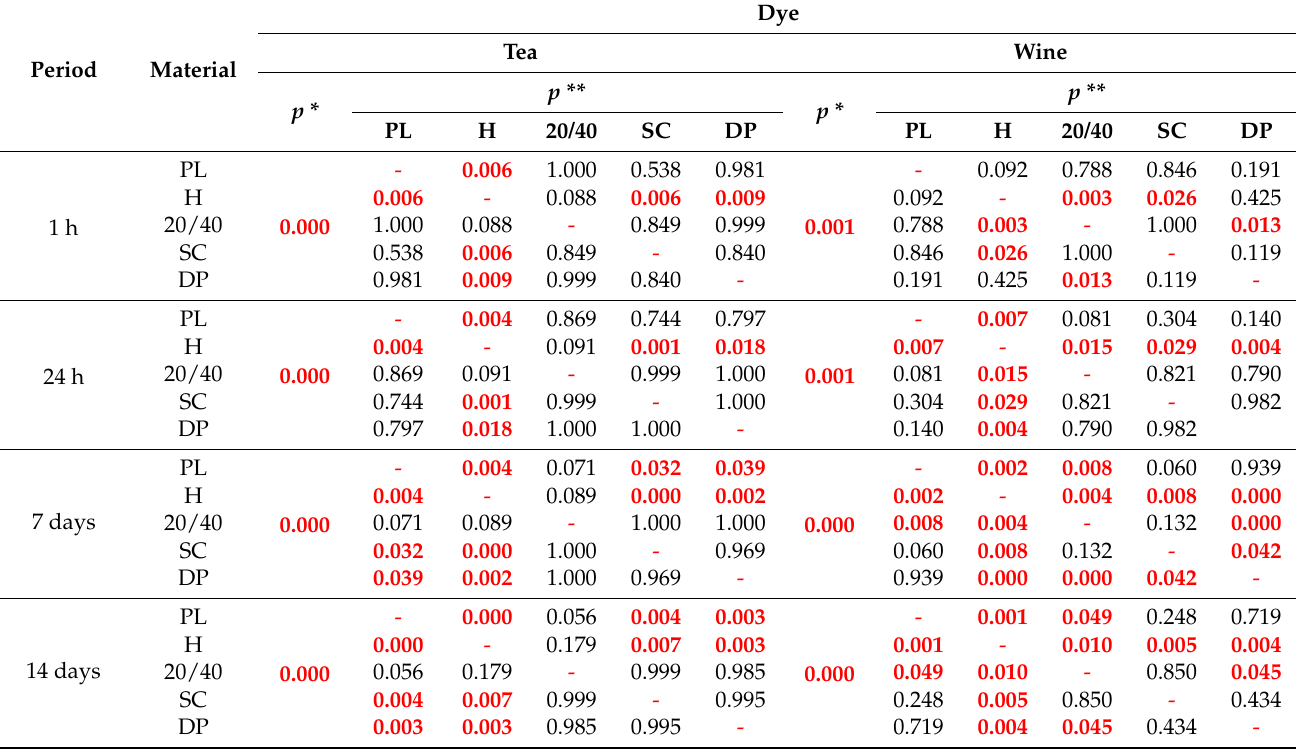
Table 8. Comparisons of ∆ E* between materials within dye (tea, wine) and period subgroups.